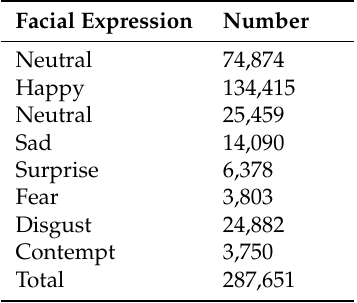
Table 2. The numbers of each category of facial expressions in Affectnet for